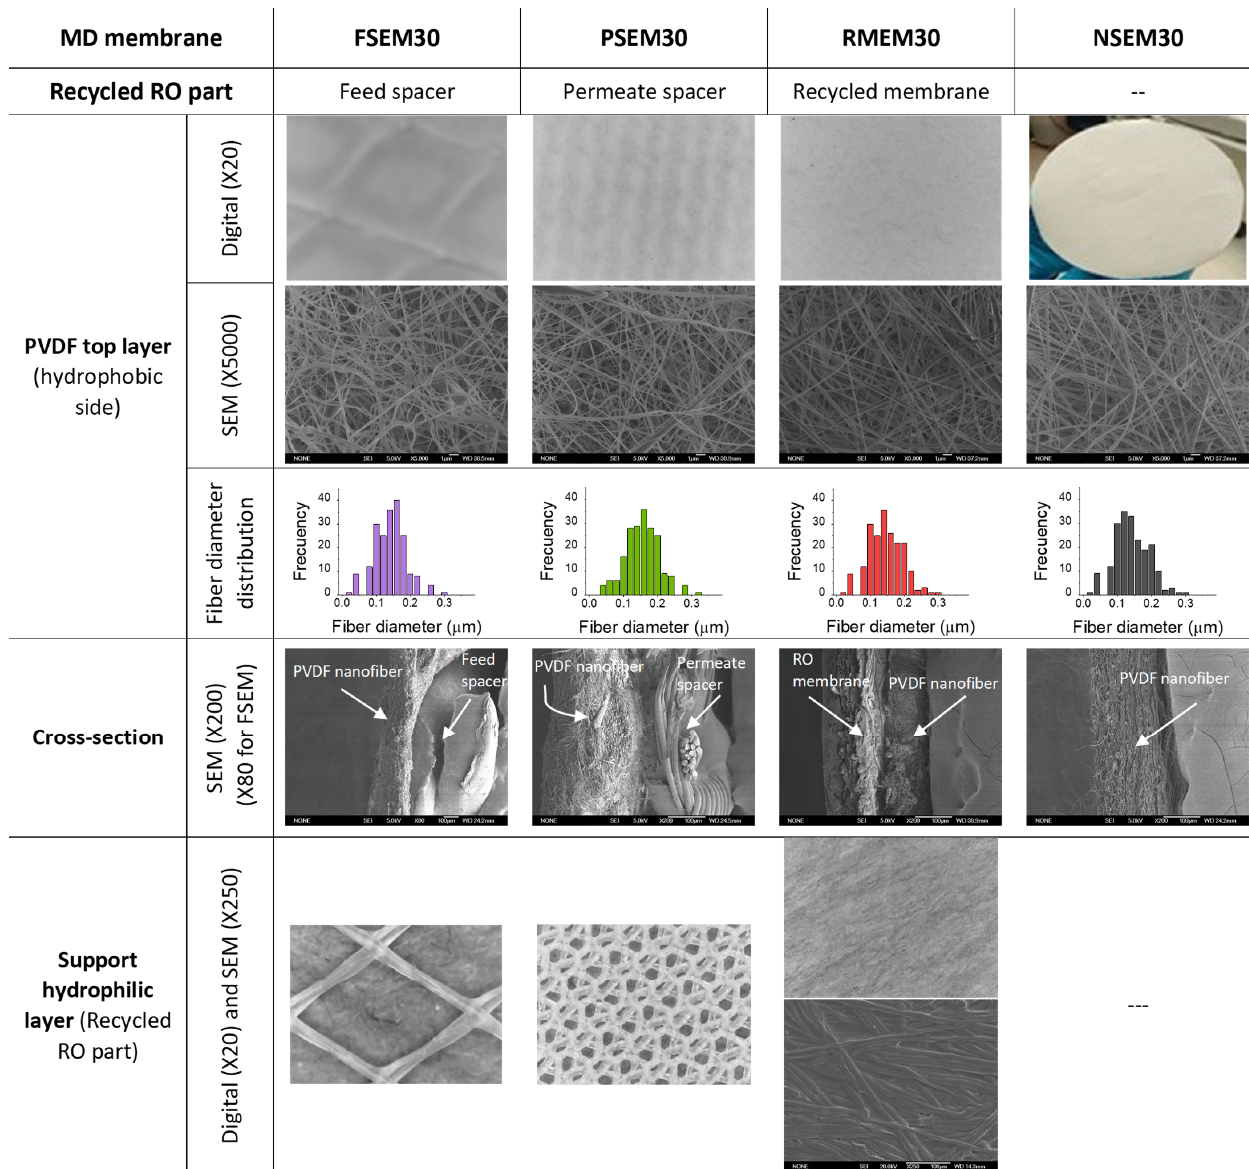
Figure 5. Digital and SEM images of the top surface of the unsupported membrane (NSEM30), feed spacer supported membrane (FSEM30), permeate spacer supported membrane (PSEM30) and RO recycled supported membrane (RMEM30) with the corresponding fiber diameter distribution of the electrospun PVDF top layer and their cross-sections SEM images and the digital images of the feed and permeate spacers and the RO membrane of the discarded RO modules reused as support of the PVDF ENMs.